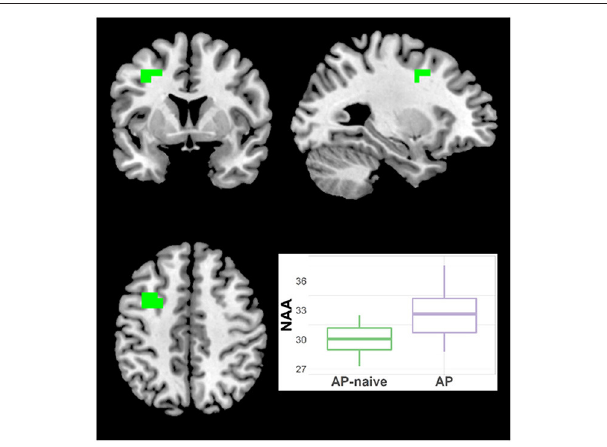
FIGURE 7 | Increased NAA in antipsychotic treated (AP) vs. antipsychotic naïve (AP-naive) Schizophrenia in one cluster: 21 voxels (CCLAV = 0.04), including the left middle frontal gyrus (61.5%%) and left precentral (15.7%). Boxplot shows weighted-average NAA cluster concentrations in institutional